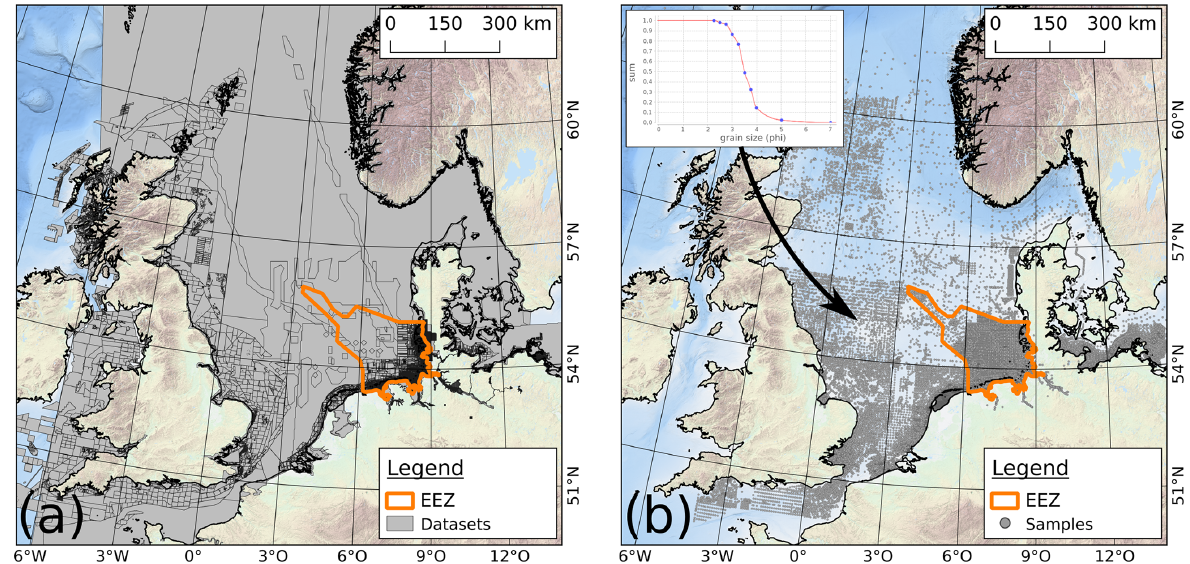
Figure 2. Spatial extent of FSM database: (a) overlapping bathymetric datasets and (b) surface sedimentological datasets represented by continuous GSD functions.